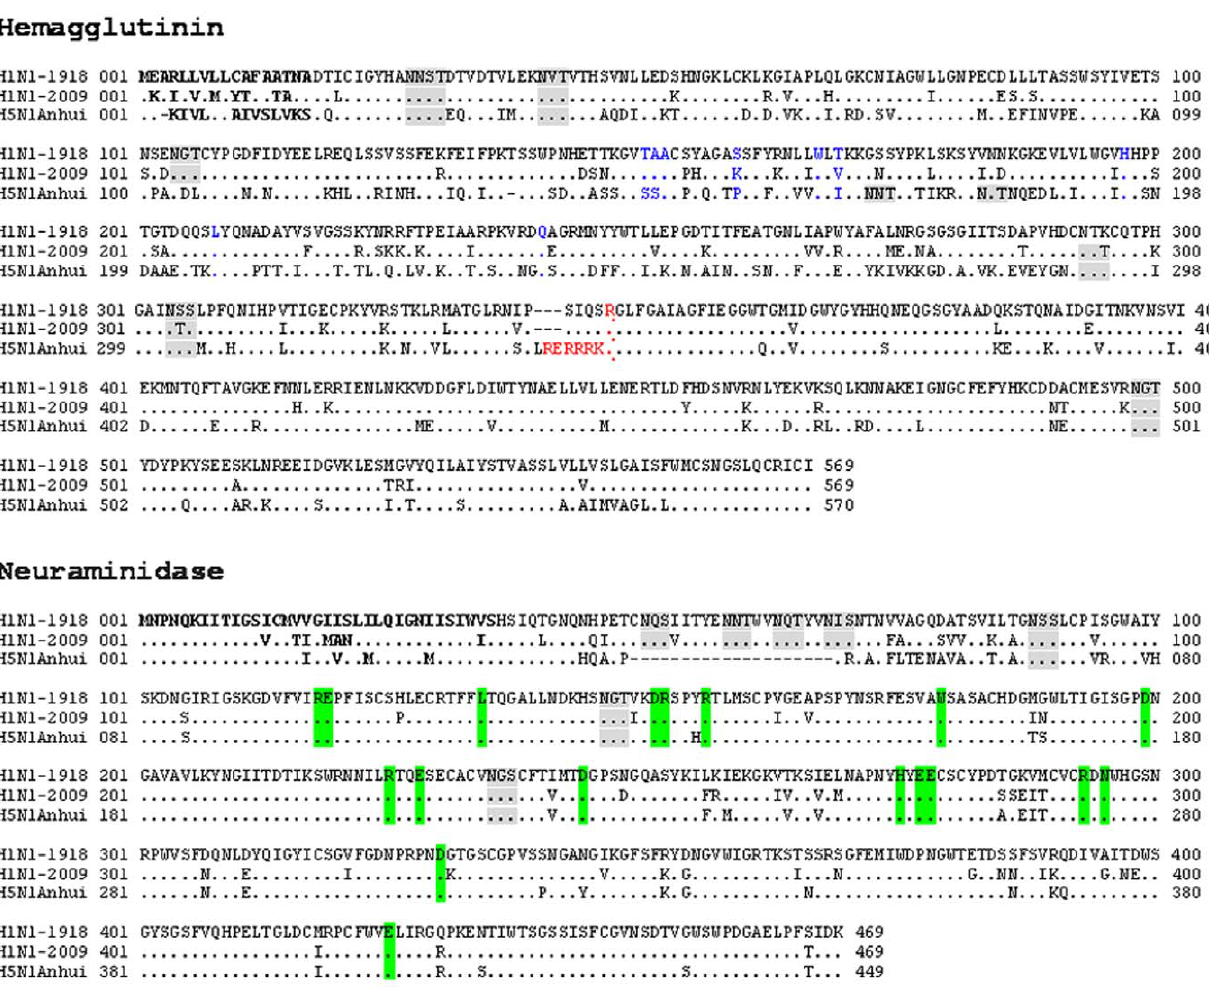
Figure 5. Primary sequence alignment of the HAs and NAs. The H1N1 1918 strain was used as a standard. Those residues that are identical in the 1918 strain are shown by ‘‘.’’ The signal peptide is indicated in bold. The aas marked in red represent the cleavage site of the HA precursor, linking the functional HA1 and HA2 domains, while those marked in blue indicate the binding sites for the sialic acid receptor. The gray boxes indicate potential glycosylation sites, as predicted from the sequence, while the green box indicates conserved active site residues from the influenza virus NA.